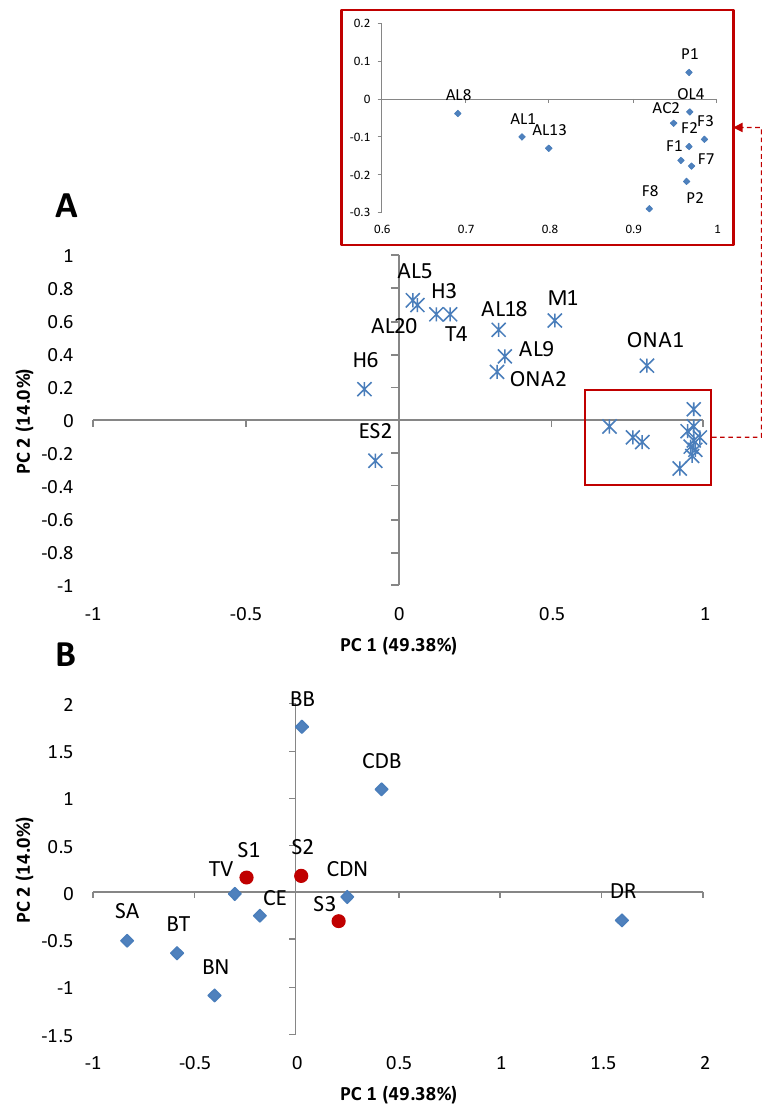
Figure 4. Loading plot ( A ) and score plot ( B ) after principal component analysis of the varieties, ripening stages, and volatile compounds in the plane by two first principal components (PC1 and PC2). Code letters for volatile compounds are shown in Table 1.